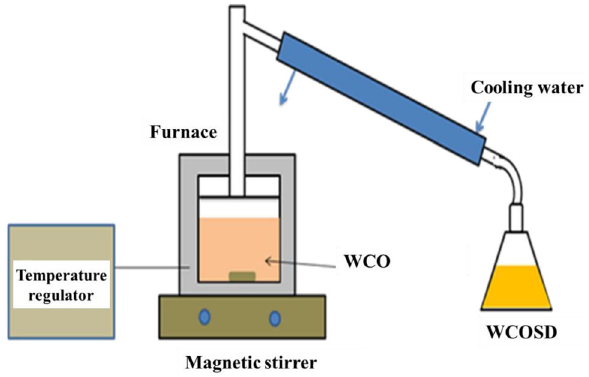
Fig. 1 Principle diagram of the WCO cracking